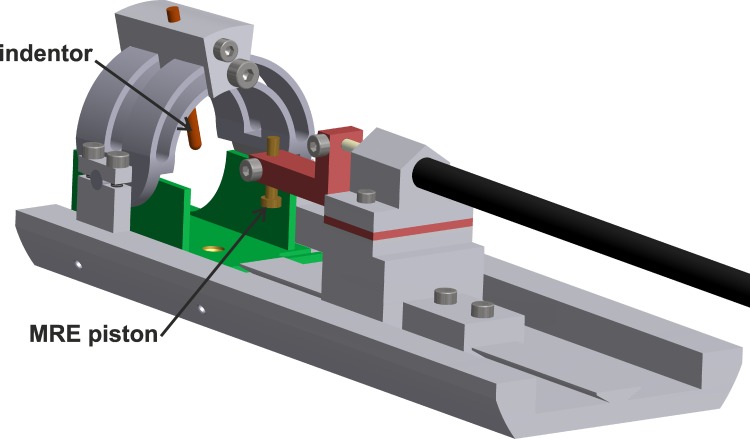
Detail of indentation and MRE actuator part of setup.Indentor and MRE piston are indicated with a label. Indentor can be positioned on the rats TA using the movable indentor holder. The MRE piston is coupled to the tendon at the distal side of the TA muscle. Overview figure indicating all parts is shown in online supplemental S2 Fig.